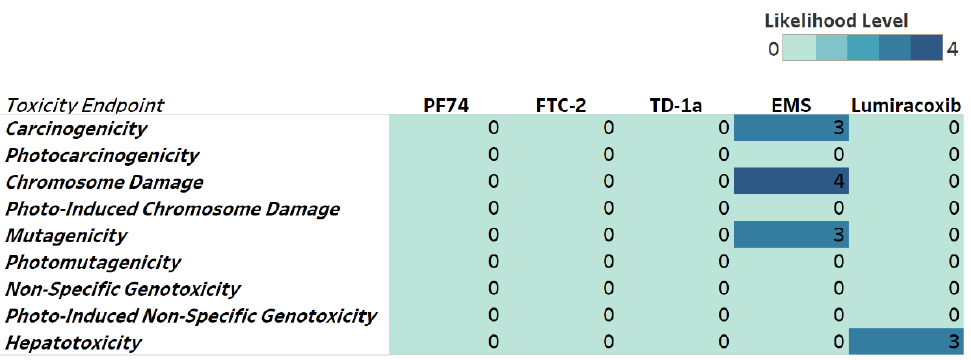
Figure 6. Computational prediction of metabolic stability. ( A ) Prediction of the major metabolizing CYP isoforms. All compounds are predicted to be metabolized primarily by the 3A4 isoform, including PF74 . ( B ) Overall composite site lability (CSL) score and number of labile sites within the compound (for metabolism). A lower CSL score indicates a more stable molecule. The prediction was achieved using the StarDrop (version 7) P450 module. ( C ) Predicted affinity of docked FTC-2, TD-1a , and PF74 to Cytochrome P450 3A4 (PDB ID: 4D78). The lower boundary for predicted 3A4 affinity